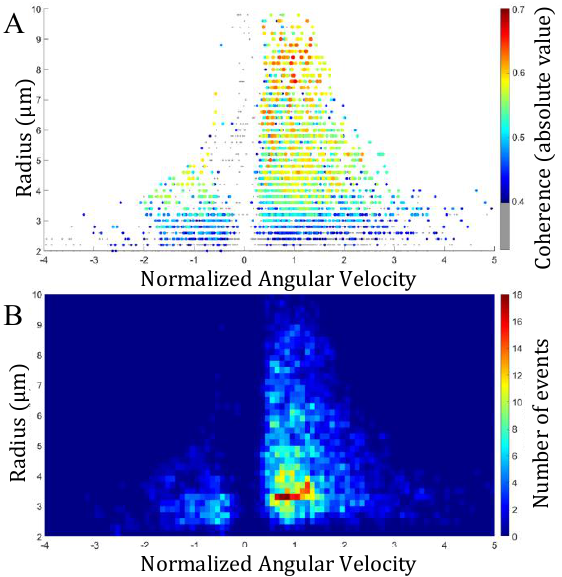
Fig. 6. A. All events sorted by radius R and normalized angular velocity, and color-coded by coherence; B. statistical distribution of events (restricted to coherence larger than 0.4 in absolute